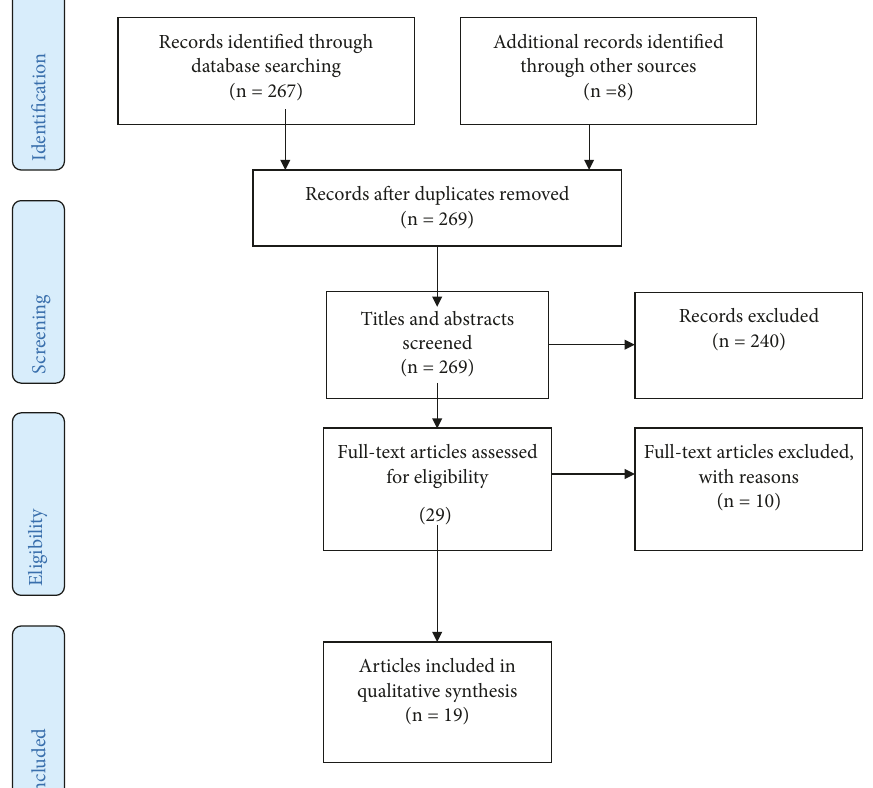
Figure 1: Flow-diagram of search